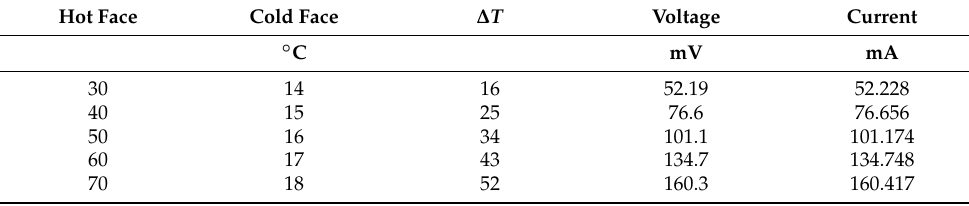
Figure 19. Output voltage Vp and current Ip for an Rp = 1 Ω . Table 3. List of measurements of electrical power generation under specific ∆ T